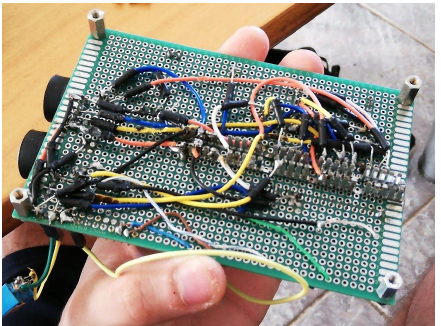
Figure 6. Communication between D1 and